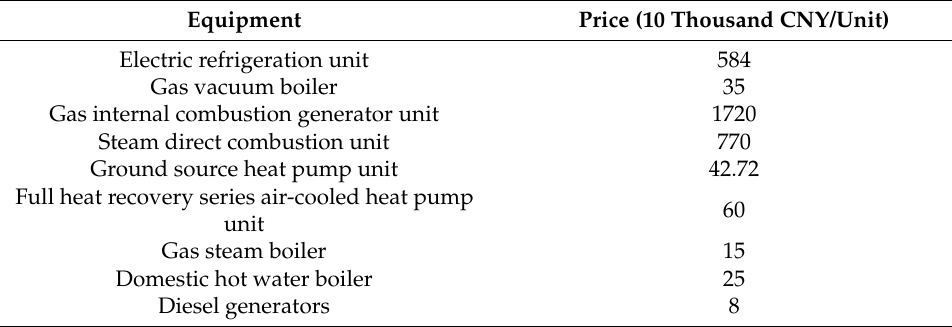
Table A6. Main equipment price.